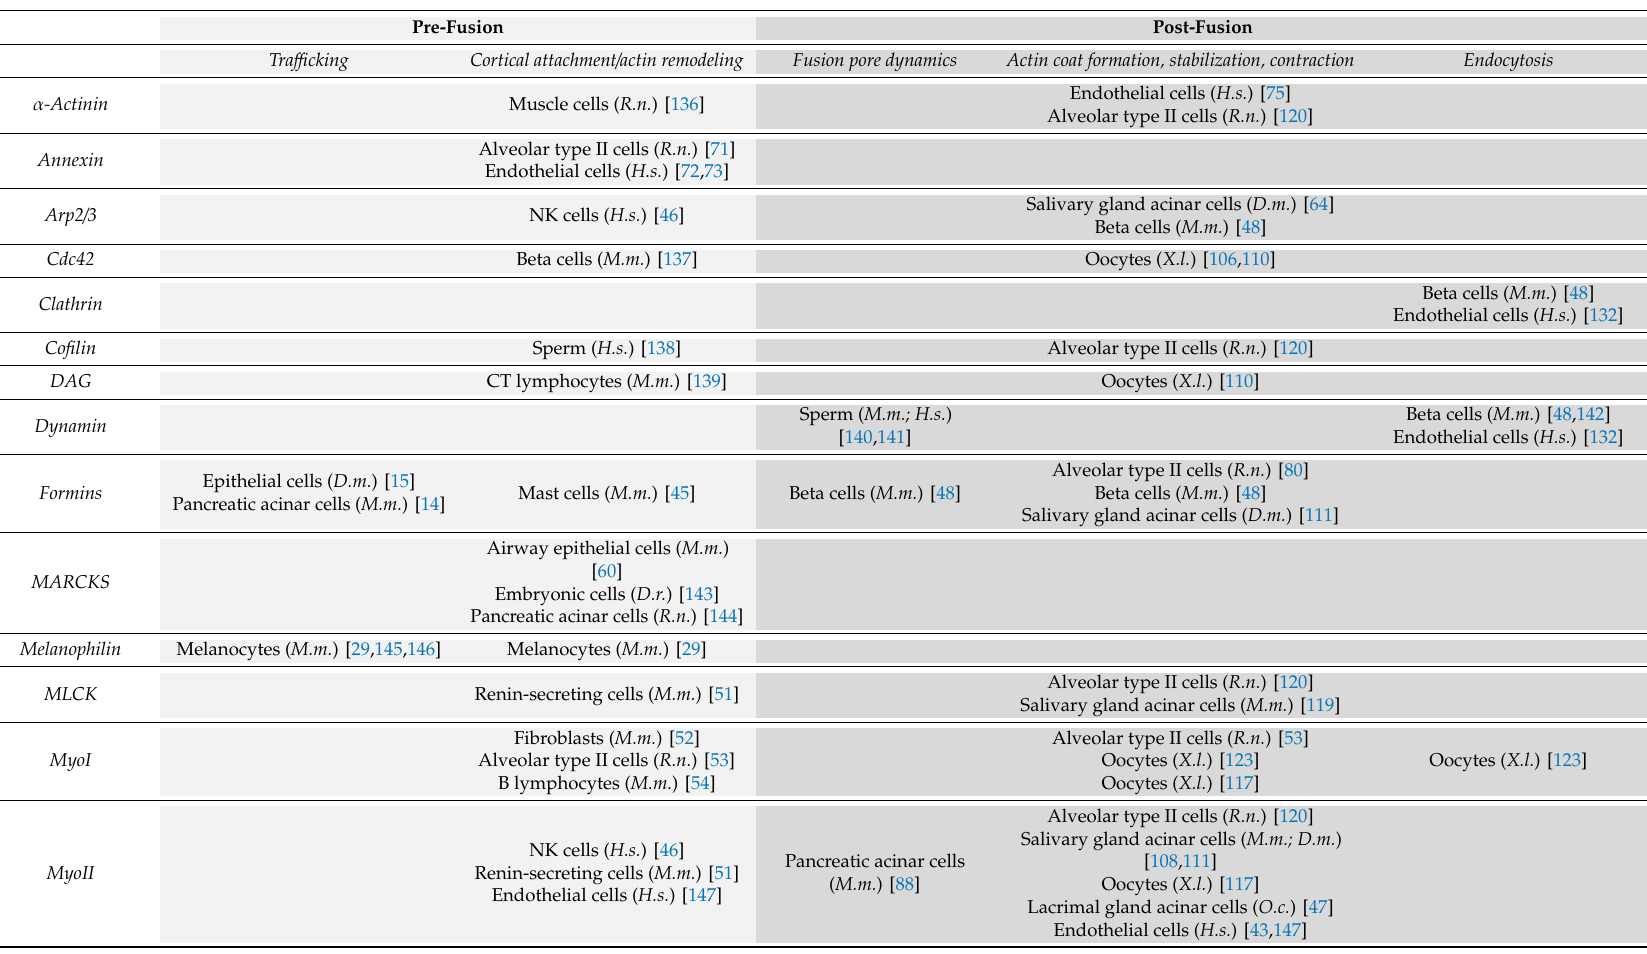
Table 1. Structural and regulatory proteins and lipids found to be involved in pre- and post-fusion stages of exocytosis in various non-neuronal secretory cells. Abbreviations: D.m. , Drosophila melanogaster ; D.r. , Danio rerio ; H.s. , Homo sapiens ; M.m. , Mus musculus ; O.c. , Oryctolagus cuniculus ; R.n . Rattus norvegicus ; X.l. , Xenophus laevis